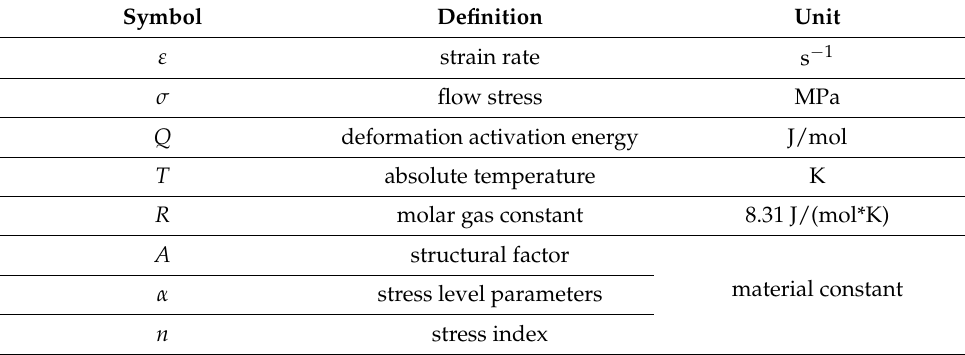
Table 6. Meaning of letters.